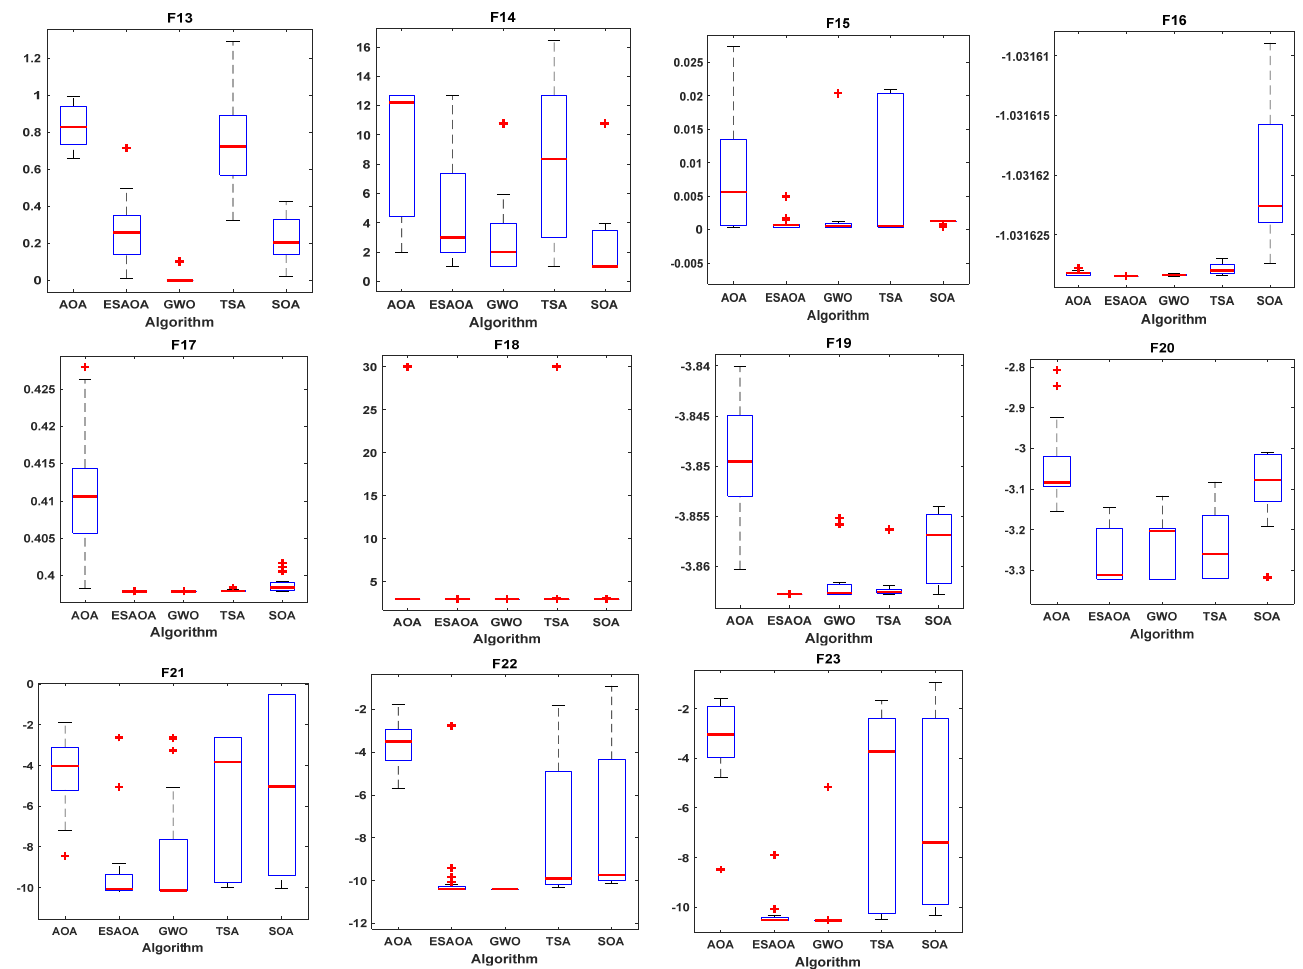
Figure 13. Boxplots for all algorithms for 23 benchmark functions.